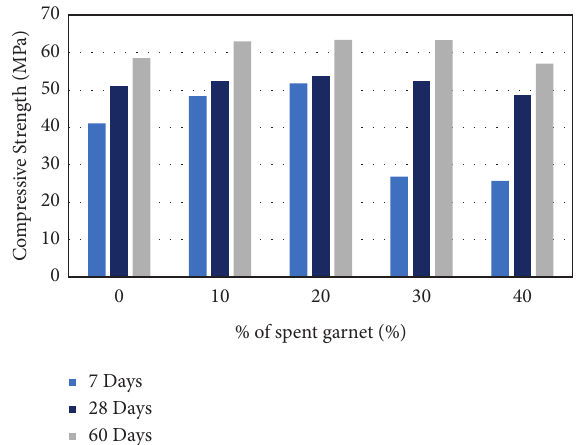
Figure 7: Compressive strength of POC LWAC containing spent